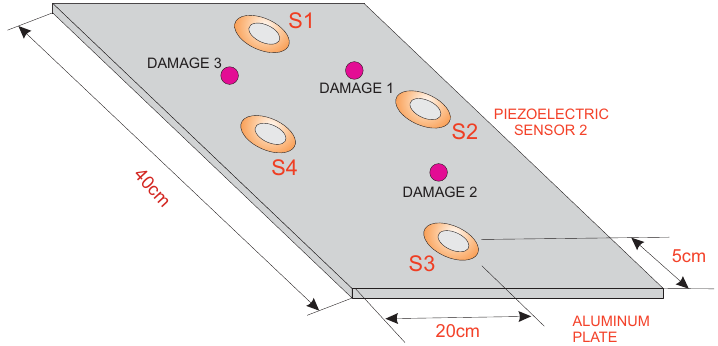
Figure 8. Aluminum plate instrumented with four piezoelectric